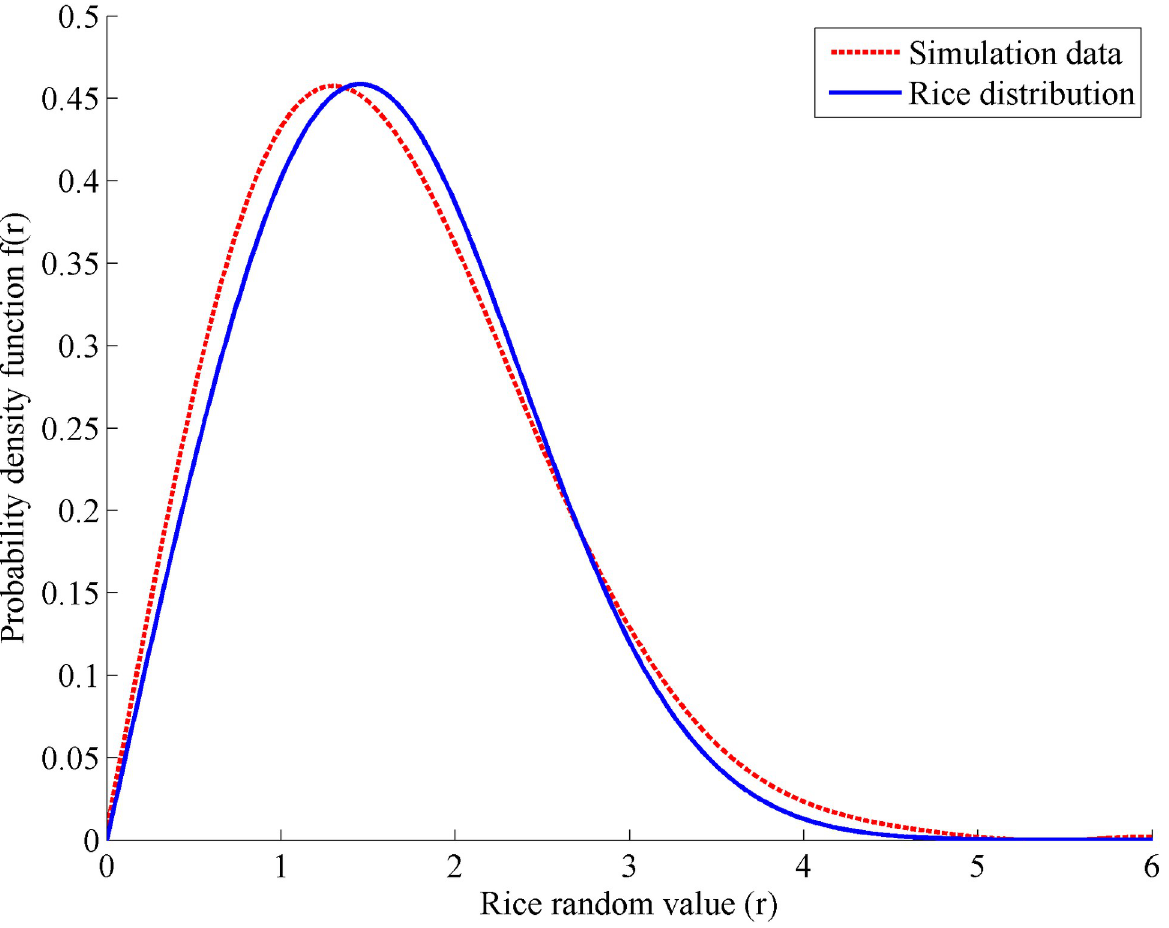
Fig 2. Fitting of simulation data with standard Rice